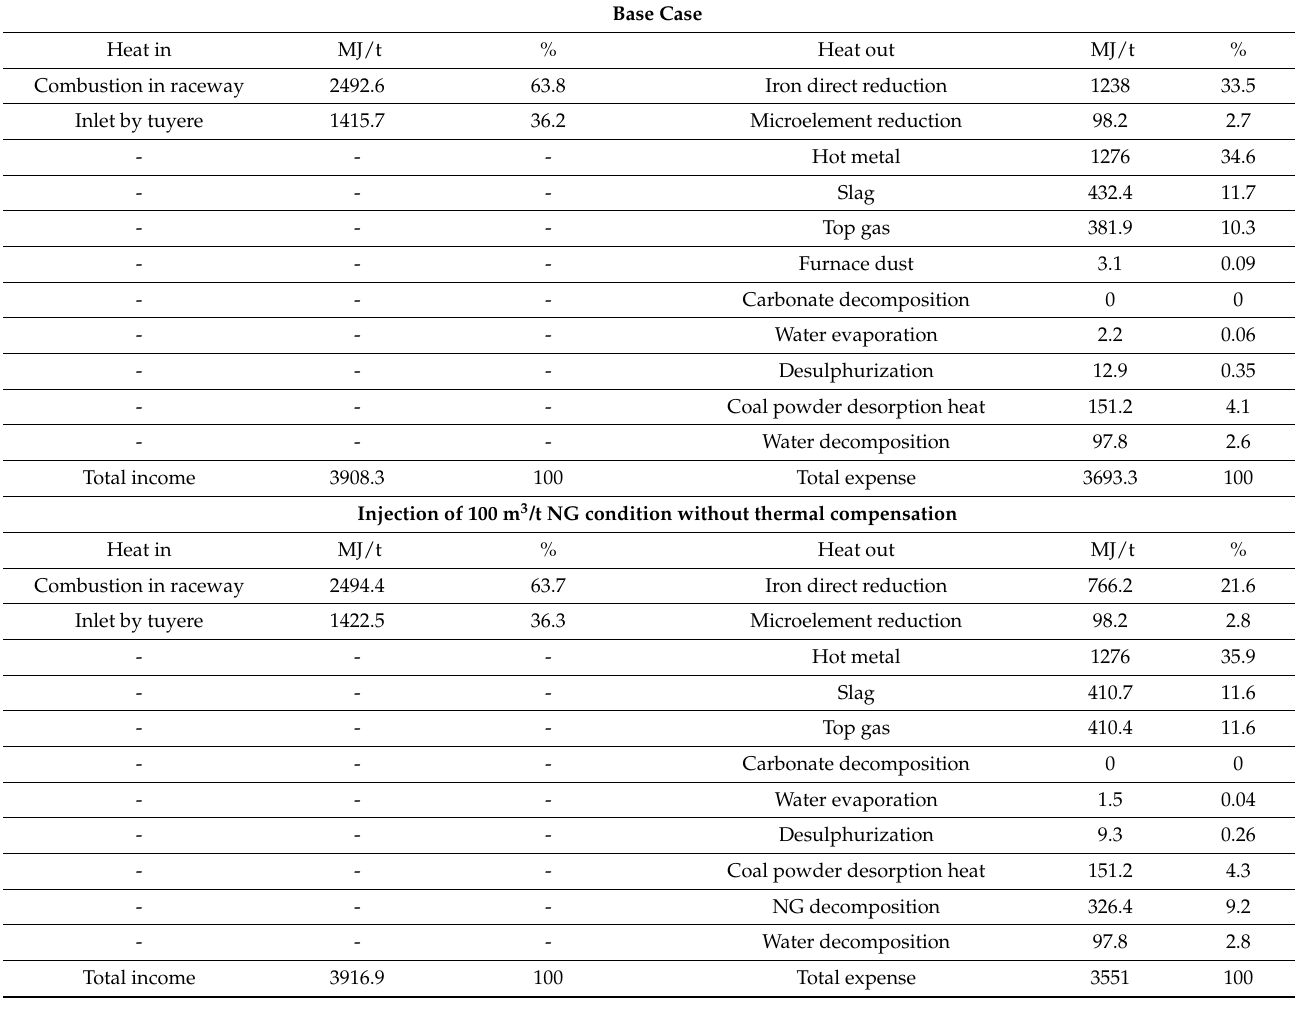
Table 4. Heat balance of whole furnace for base case and the case with 100 m 3 /t NG injection under no thermal compensation.